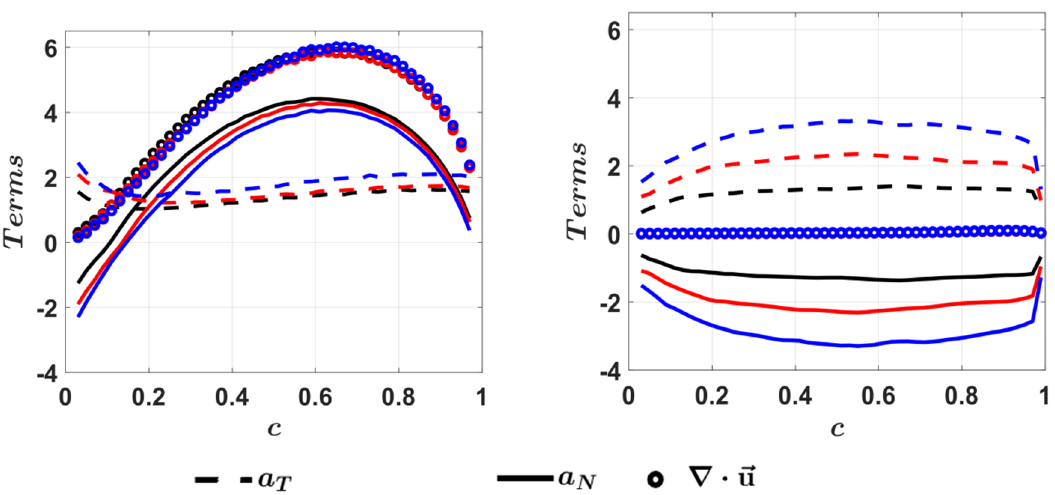
Figure 6. Profiles of the mean values of {(cid:1853) (cid:3015) , (cid:1853) (cid:3021) and ∇.(cid:1873)(cid:4652)⃗} × δ th / S L conditioned upon c for u (cid:48) / S L = 4.0 (black) 6.0 (red) and 8.0 (blue) for statistically planar turbulent premixed flames (first column) and homogeneous MILD combustion cases (second column).